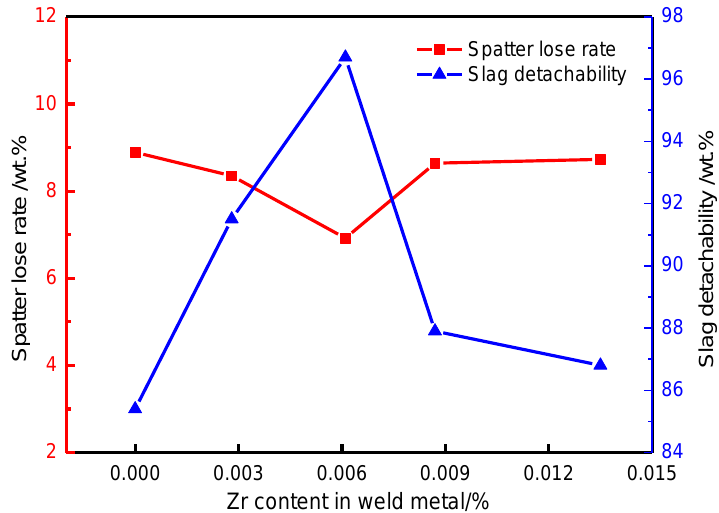
Table 7. Chemical composition of weld metal (mass, wt %).